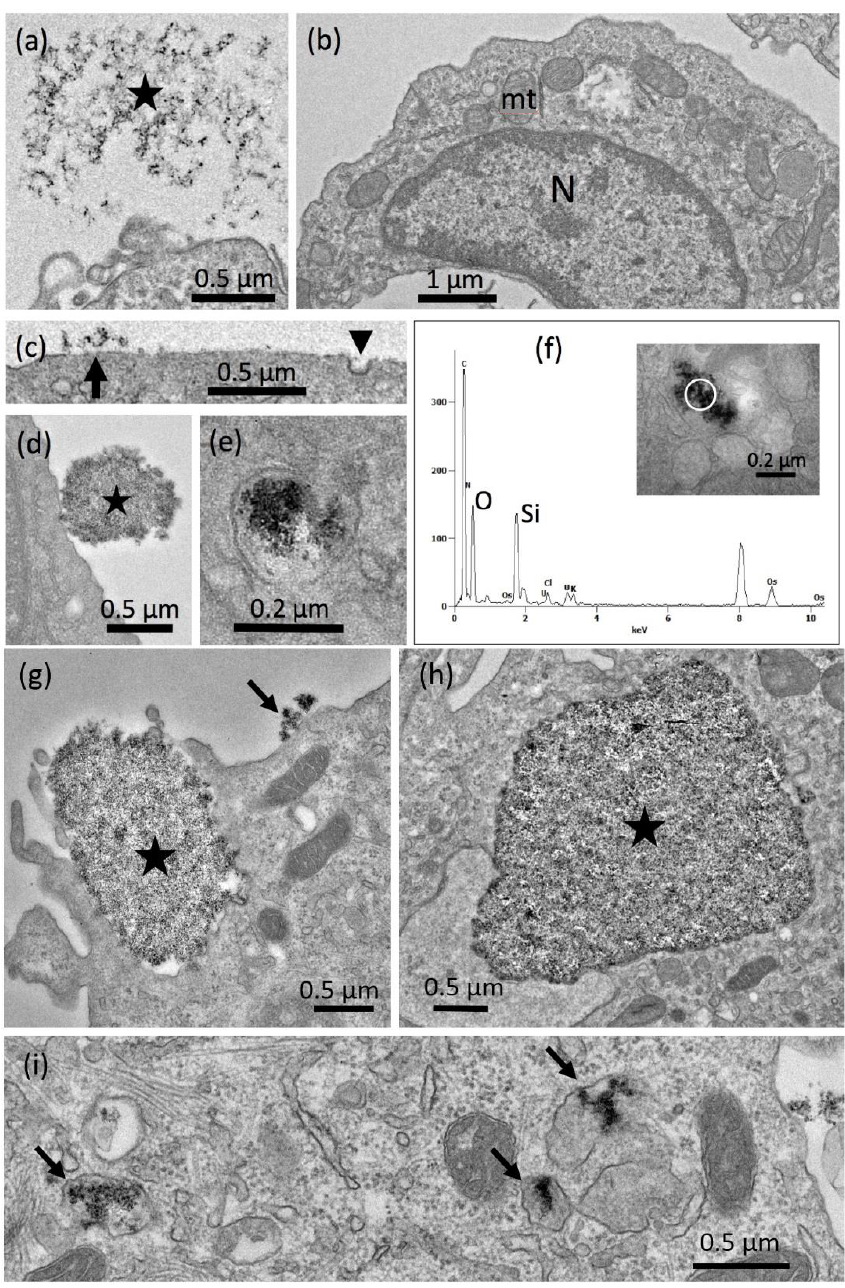
Figure 9. Detection of silica gel nanoparticles in NR8383 cells by transmission electron microscopy (TEM). Cells were treated with 90 µ g/mL G-1 ( a – f ), or 17 µ g/mL G-3 ( g – i ) in serum-free F-12K medium and fixed after 90 min ( a – c , g , h ), or 16 h ( d – f , i ). ( a ) Assembly of G-1 particles (asterisk) outside cells. ( b ) Section of a typical particle-free cell; N: nucleus, mt: mitochondria. ( d ) A small G-1 aggregate/agglomerate attached to the cell membrane (arrow). A coated pit forms in close vicinity of a G-1 particle. ( e ) Compact G-1 aggregate/agglomerate attached to a cell. ( f ) A lysosome containing electron dense G-1 material. ( f ) Energy dispersive X-ray analysis (TEM-EDX) of a G-1-containing lysosome (inset); analyzed area is marked by a white circle. Signals (in arbitrary units) were obtained for silicon (Si) and oxygen (O) at typical positions (in keV). ( g , h ) large aggregate/agglomerate of G-3 (asterisk) in the state of phagocytosis, and ( h ) fully internalized into a large phagosome. ( i ) Lysosomes filled with fine granular electron dense material